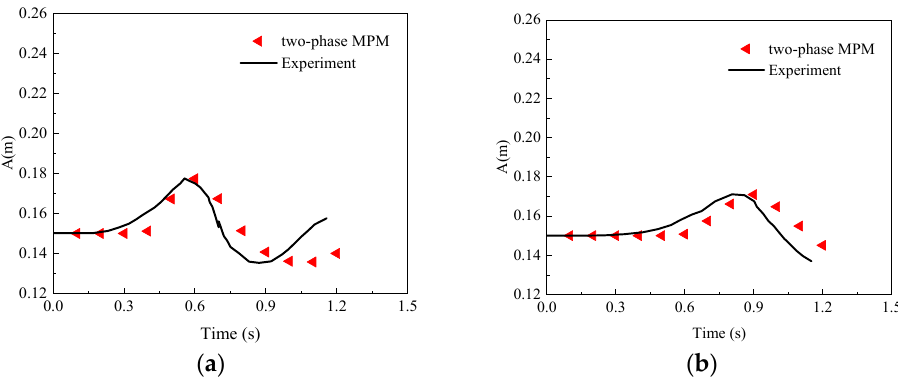
Figure 9. Comparison of wave height test results with numerical results at two different locations: ( a ) X1 = − 0.3 m; ( b ) X2 = − 0.6 m.